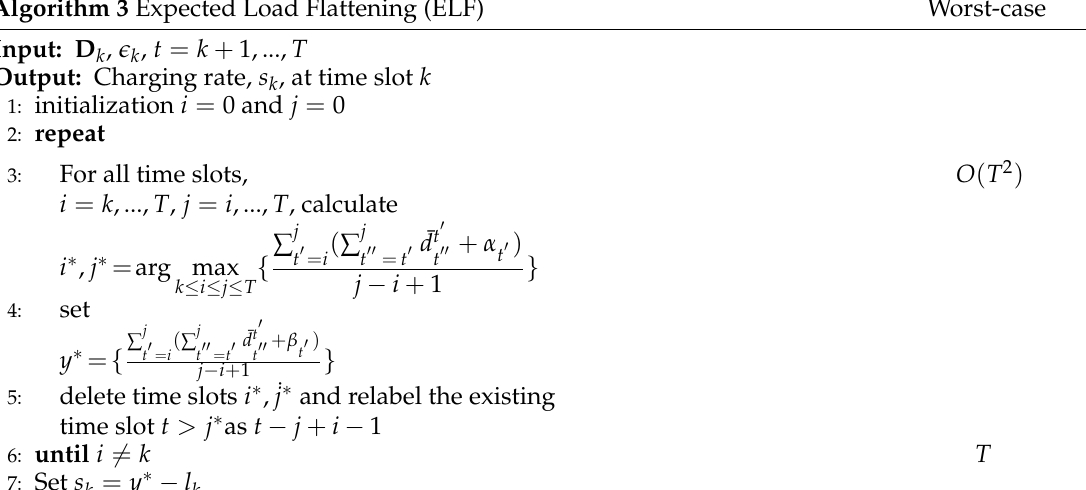
Algorithm 3 Expected Load Flattening (ELF)